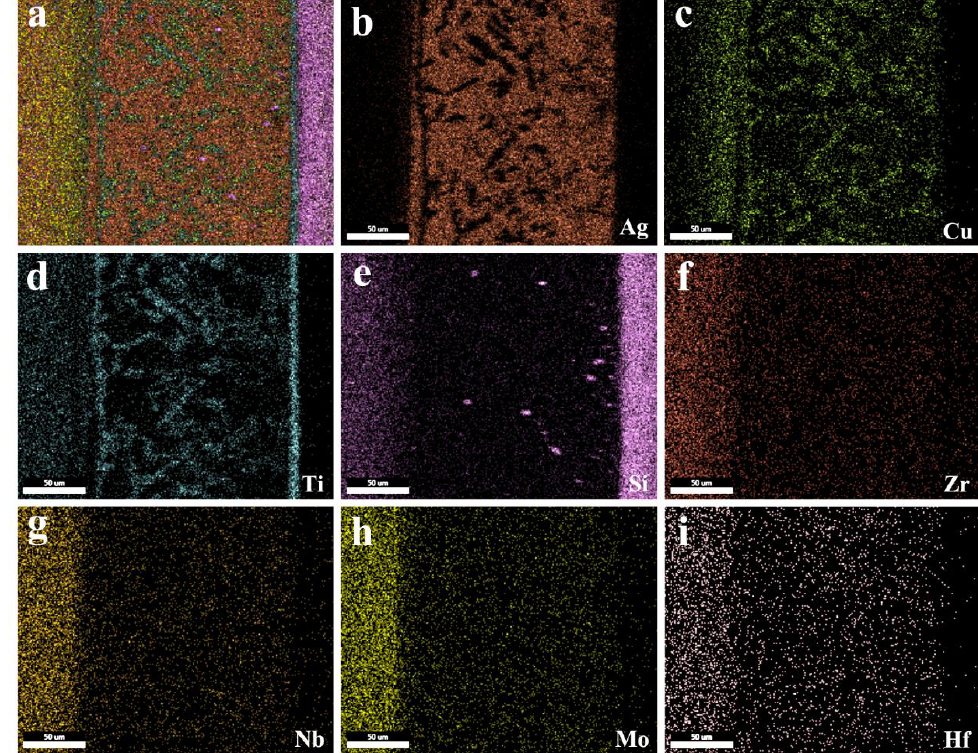
Figure 4. Elemental analysis results of the TiZrHfNbMo HEAs/AgCuTi/Si 3 N 4 joint brazed at 840 °C. ( a ) Interfacial microstructure; ( b – i ) element distribution of Ag, Cu, Ti, Si, Zr, Nb, Mo, and Hf.